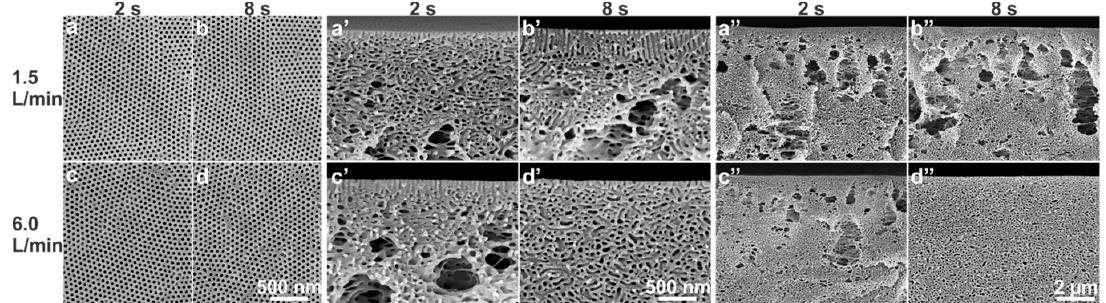
Figure 9. SEM micrographs of the top surfaces ( a – d ) and the surfaces of cross-sections ( a’ – d’ , a’’ – d’’ ) of the flat sheets cast using block copolymer solution of 27 wt% PS- b -P4VP 17139 in DMF/THF 1/1 (wt/wt). As mentioned on the micrographs, the casting parameters were Q g of 1.5 and 6.0 L/min for t g of 2 and 8 s.